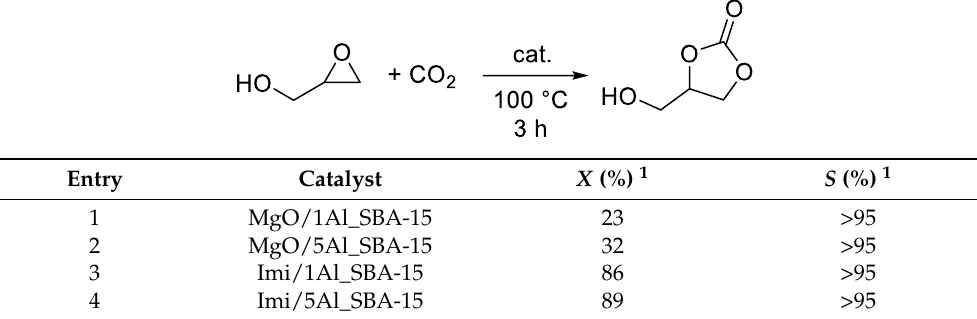
Table 2. Catalytic results for glycidol conversion to the corresponding cyclic carbonate.